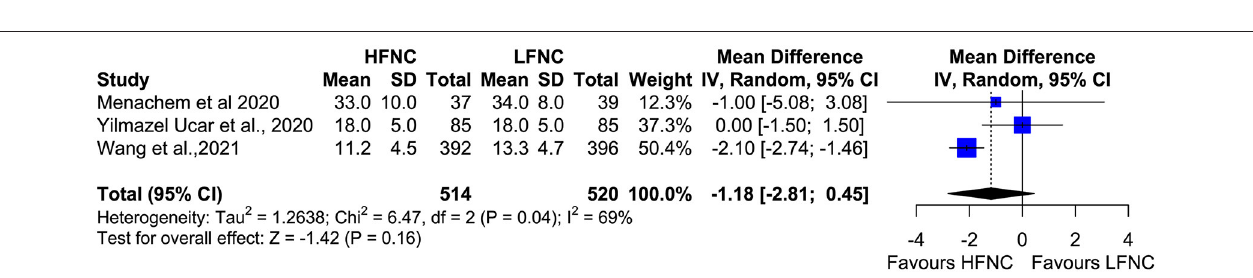
FIGURE 7 | Meta-analysis of the duration of procedure in patients receiving HFNC compared to LFNC in patients undergoing bronchoscopic procedures.